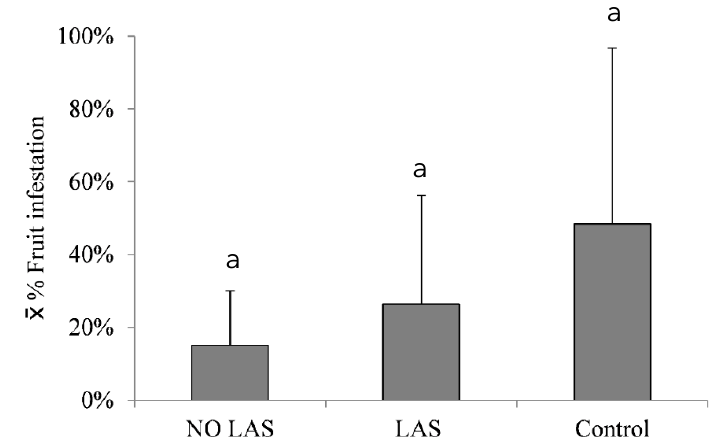
Figure 18. Average percentage of fruit infestation in NO-LAS, LAS, and control plots ± S.D. from fruits collected weekly from 27 August 2015 to 28 October 2015. Values followed by the same letter indicate no significant differences among plots (Kruskall – Wallis test, p > 0.05).